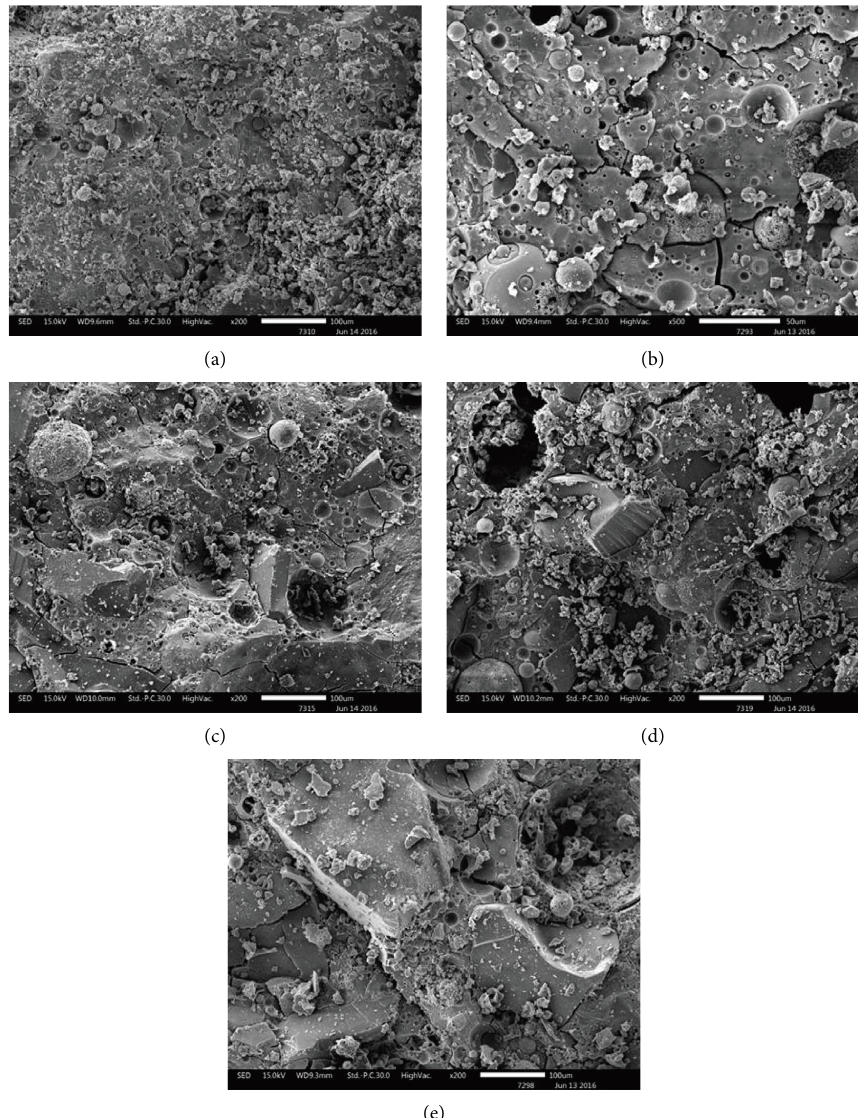
Figure 4: SEM images of a 28-day-cured AAFA: (a) FA-0RG, (b) FA-25RG, (c) FA-50RG, (d) FA-75RG, and (e)